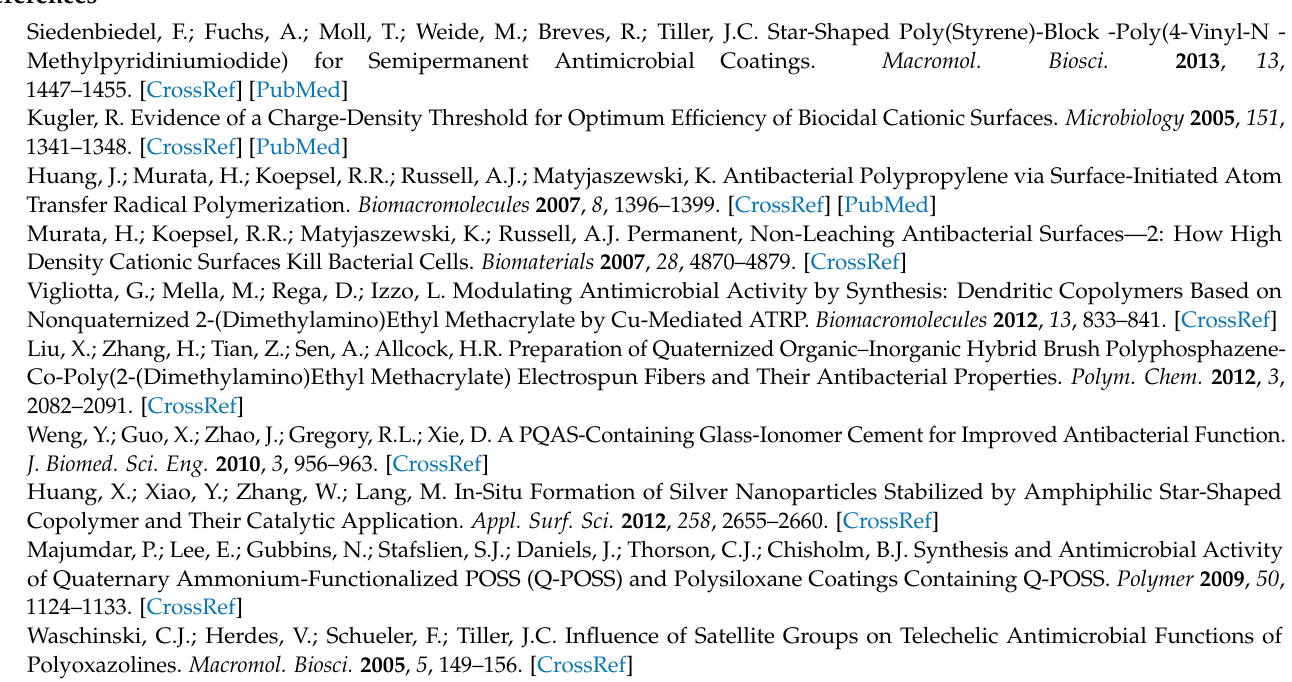
Figure S1. The AFM phase images of P(DMAEMA-co-OEGMA-OH) star layers after